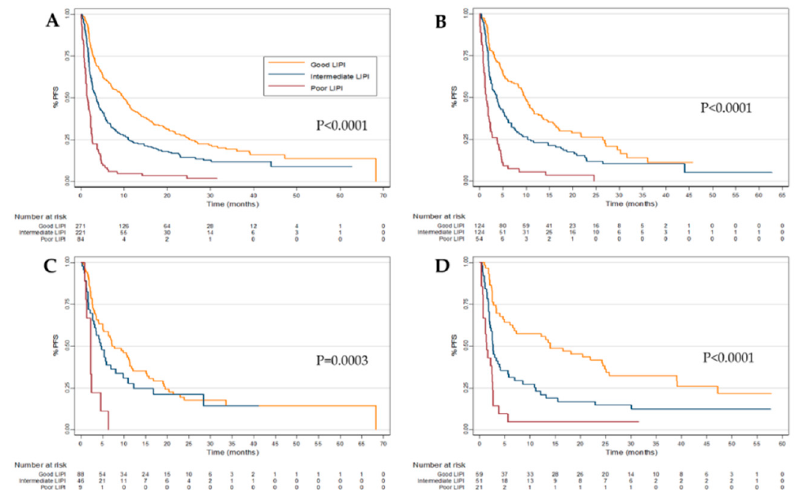
Figure 2. Progression-free survival (PFS) according to Lung Immune Prognostic Index (LIPI) group in the ( A ) pooled, ( B ) Non-small cell lung cancer (NSCLC), ( C ) Renal cell carcinoma (RCC) and ( D ) melanoma cohorts.